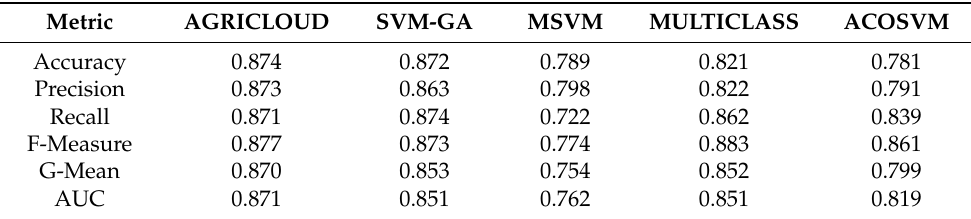
Table 4. Comparative analysis of AGRICLOUD with Classification Techniques.